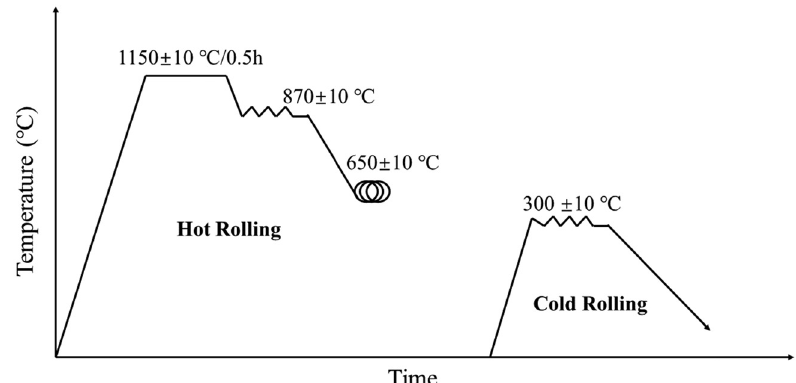
Figure 1: Schematic diagram of the rolling process.